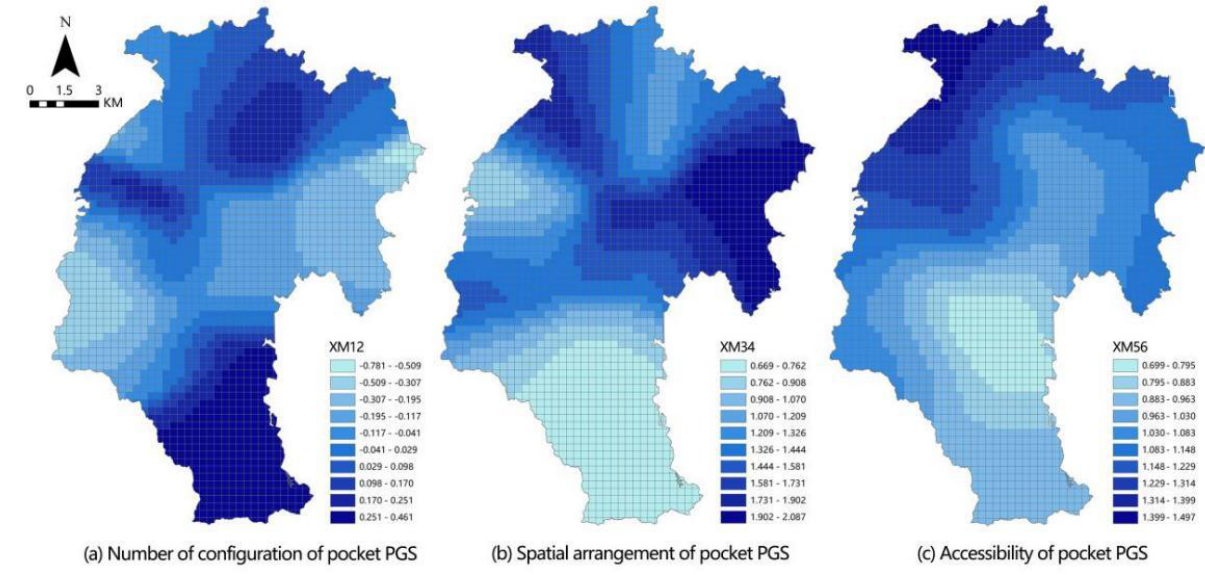
Figure 9. Spatial patterns of correlation coefficients between subsystems of pocket PGS and CCD.